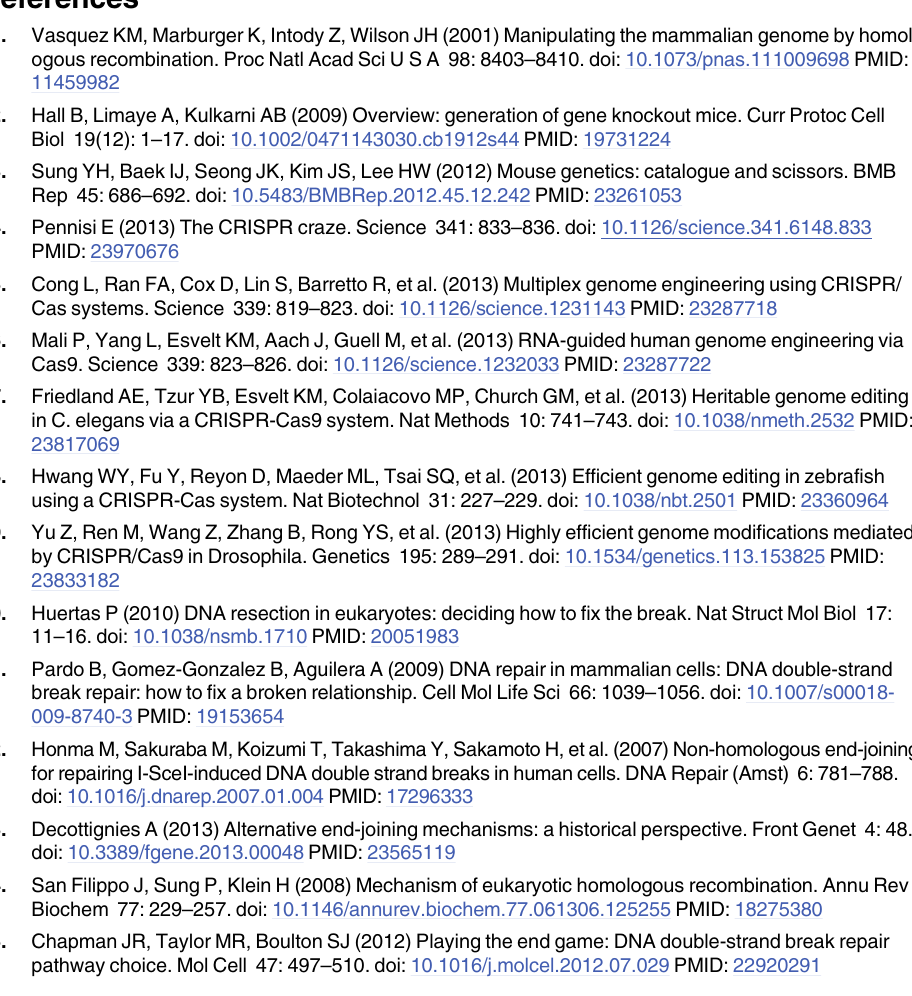
S1 Table. Off-target sites for the sgRNAs used in this study. S2 Table. Characteristics of founder mice analyzed for off-target